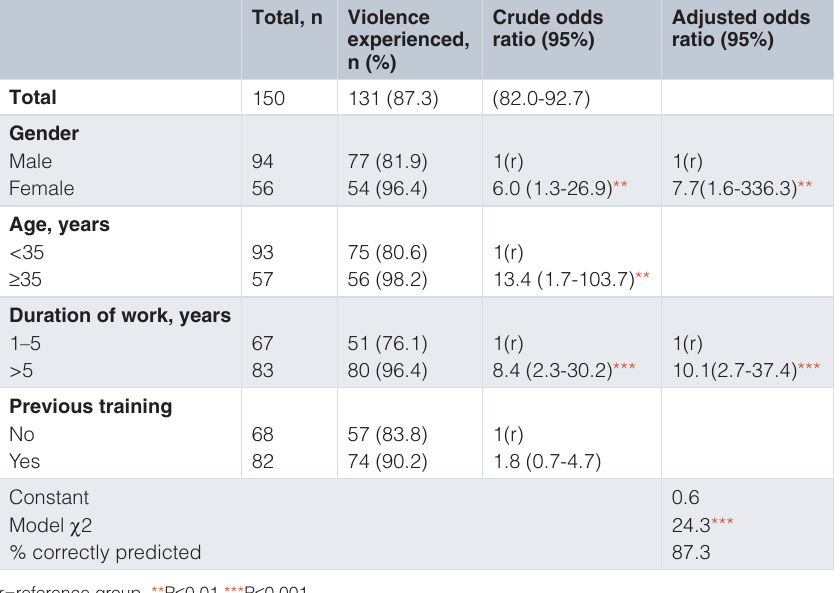
Table 1. Prevalence of workplace violence against security personnel at a university hospital in Egypt and its predictors during past year.